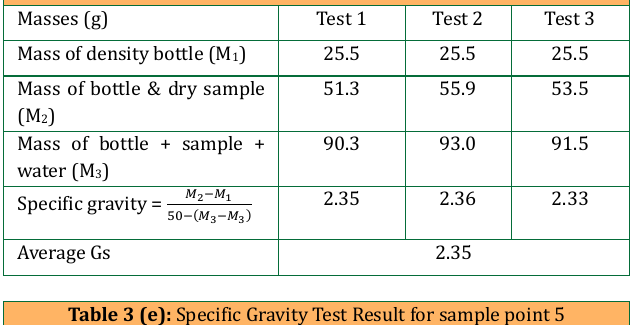
Table 3 (d): Specific Gravity Test Result for sample point